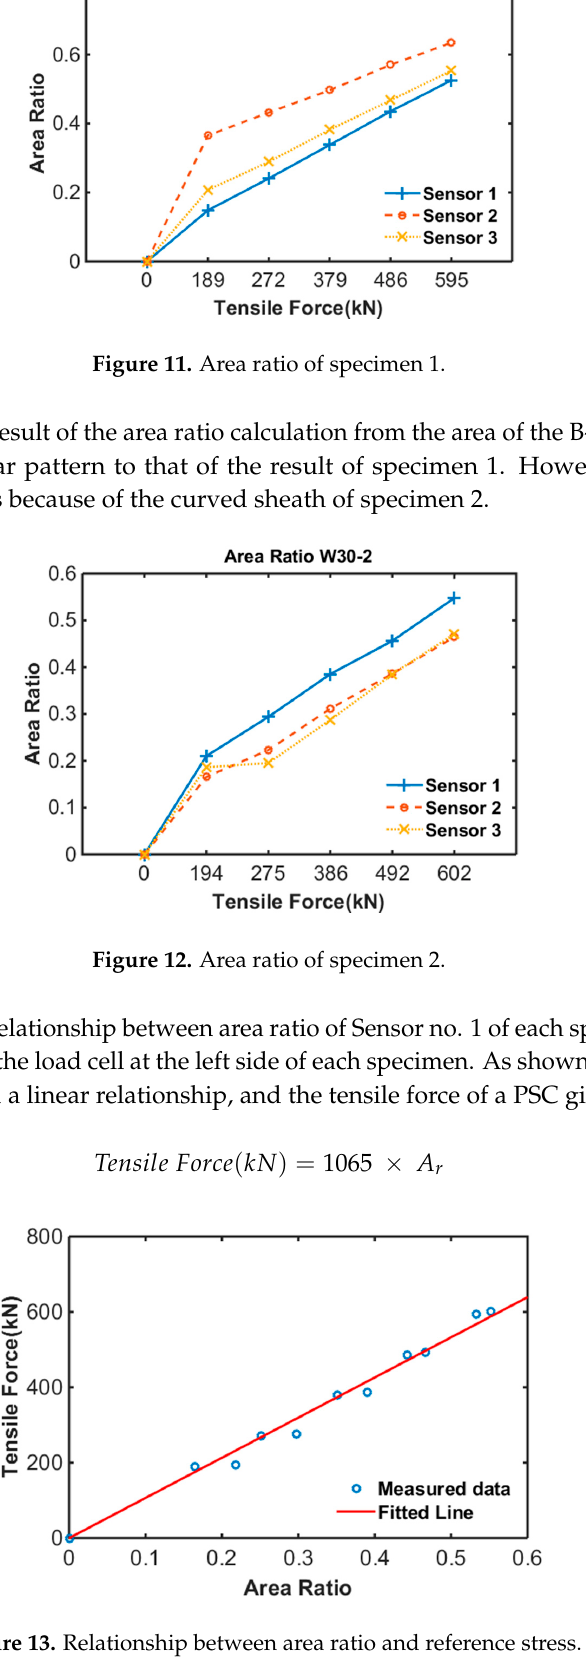
Figure 13 . Relationship between area ratio and reference stress . Figure 13. Relationship between area ratio and reference